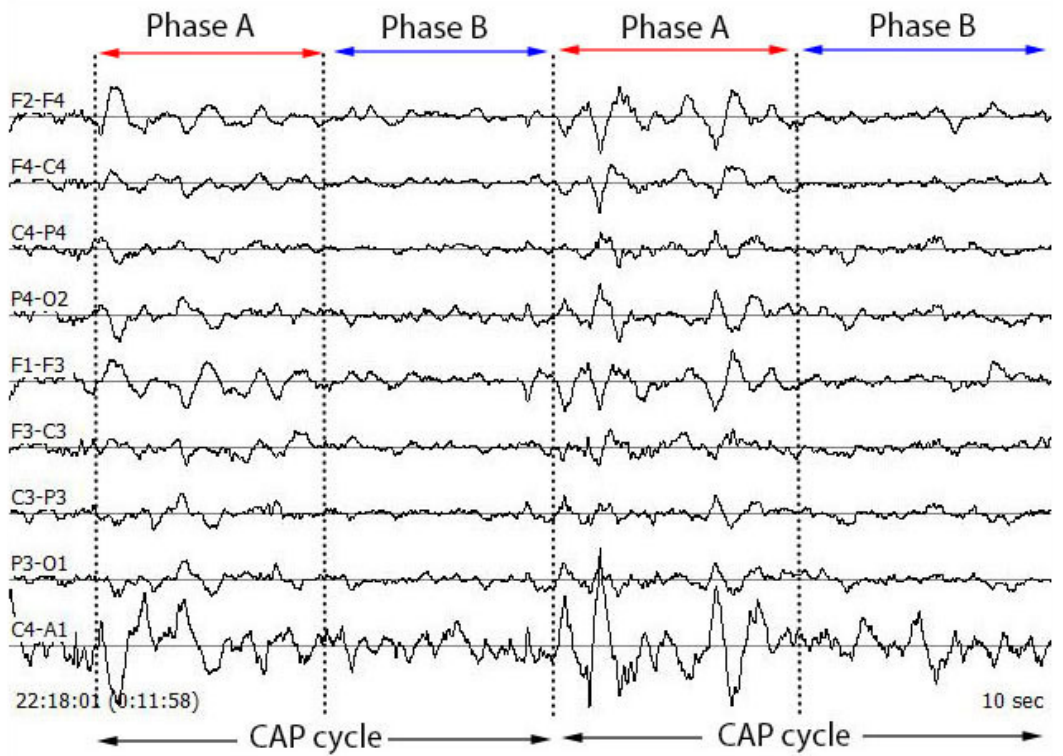
Figure 1. Typical multi-channel image of a CAP cycle with phase A and phase